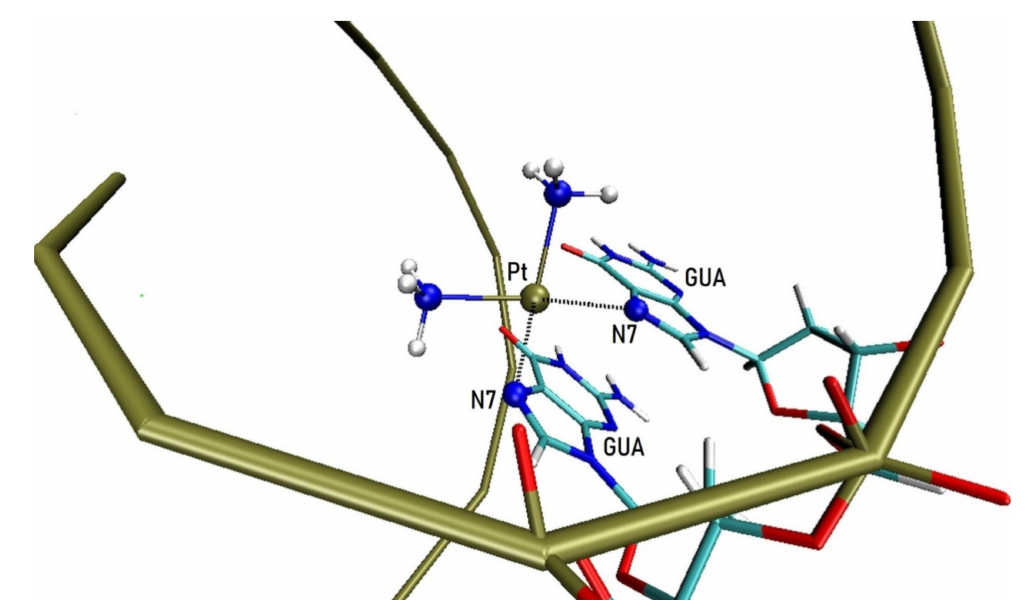
Figure 4. The crosslink of carboplatin with Guanine (GUA) on the